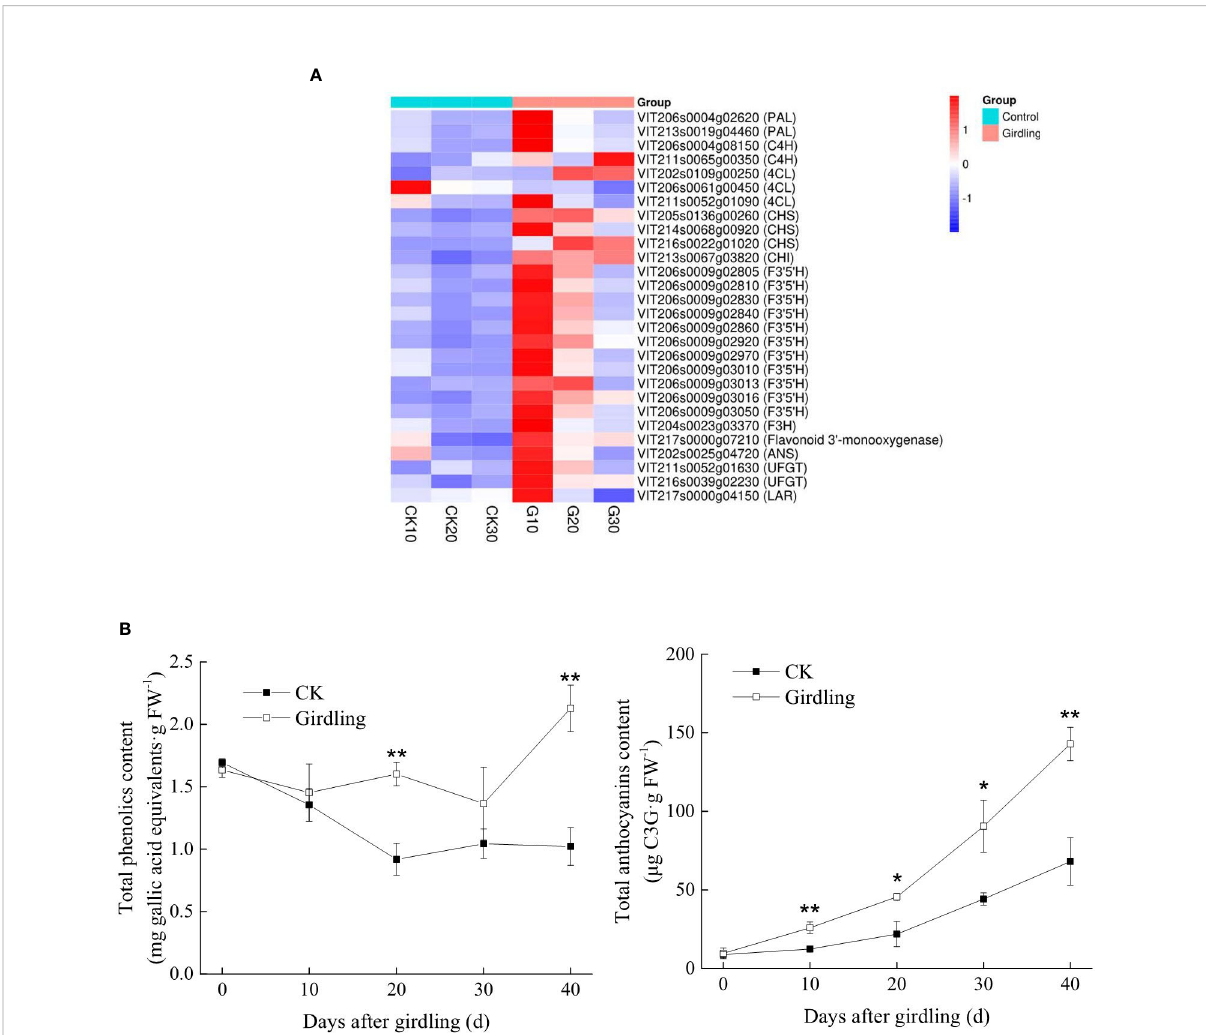
FIGURE 5 Effects of girdling treatment on fruit color change in ‘ Summer Black ’ . (A) Heatmap of DEGs related to anthocyanin biosynthesis. TPMs of genes were used in the analysis after row z-score scaling. DEGs are labeled by gene ID (description). 4CL, 4-coumarate coenzyme A ligase;